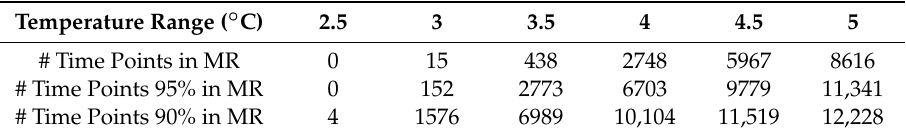
Table 1. Number of time periods identified by Maximum Range (MR).